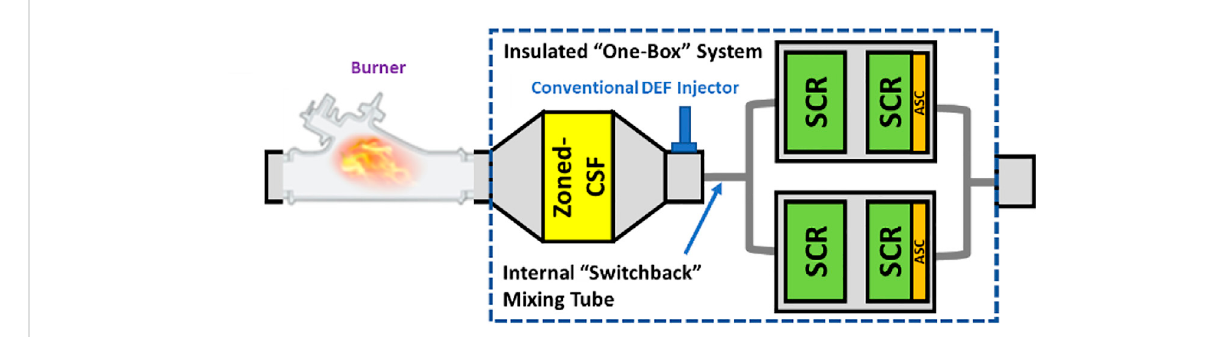
FIGURE 4 Burner con fi guration of the CDA + LO-SCR + Primary system.